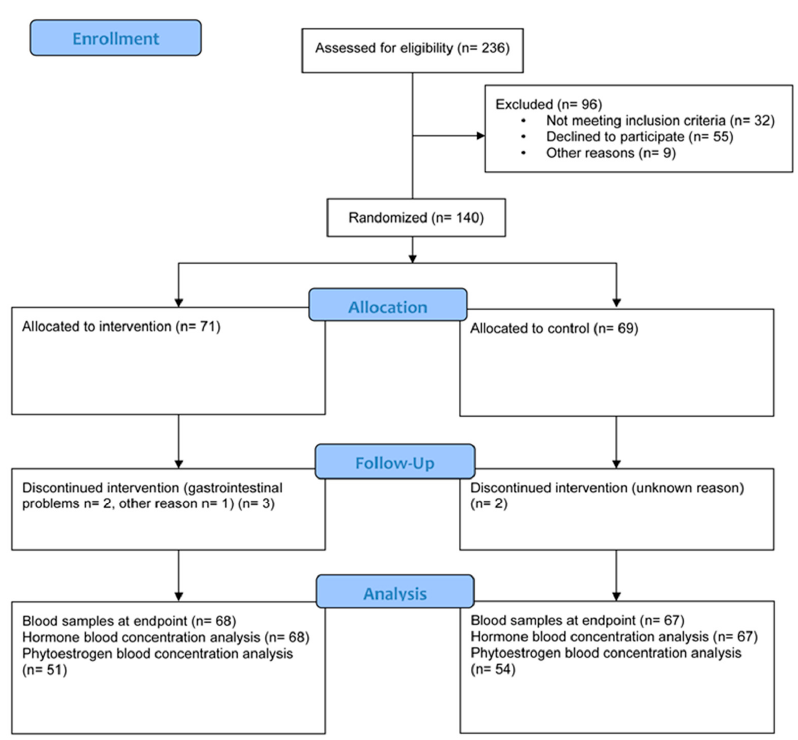
Figure 3. Flowchart of the PRODICA study.